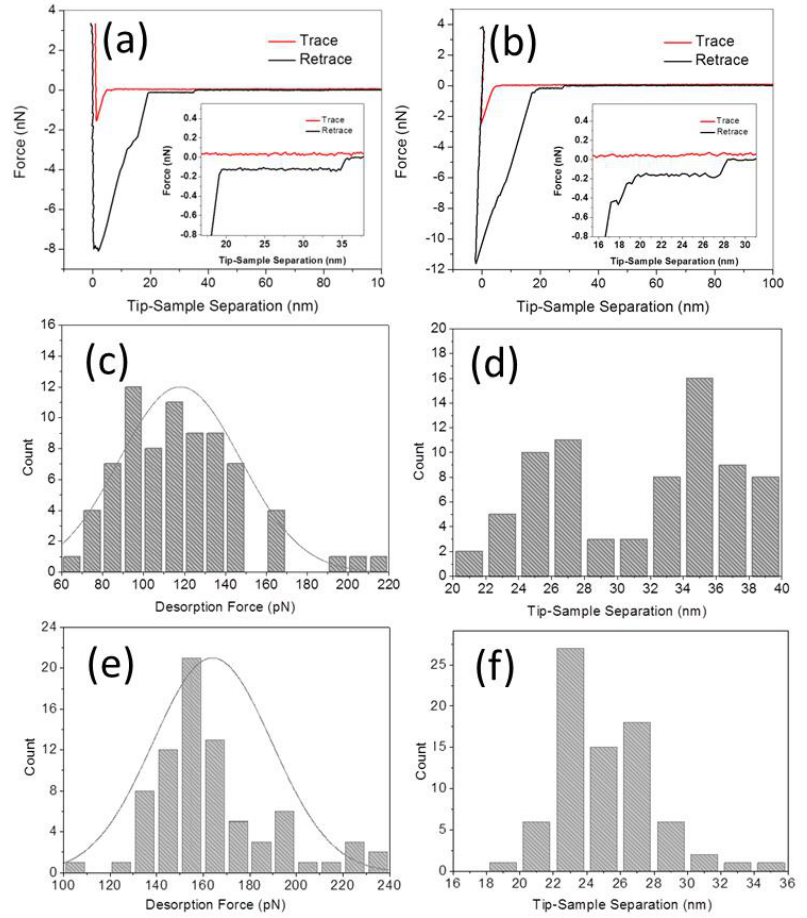
Figure 4. SMFS experiments and statistical analysis: ( a , b ) Typical FD curve by peeling aptamer from graphite surface ( a ) before and ( b ) after adding 1 μM adenosine; ( c , d ) Distributions of the desorption forces and tip-sample separations corresponding to the FD curves of ( a ); ( e , f ) same, for the FD curves of ( b ). After the adding of adenosine, the mean desorption force by peeling aptamer from graphite surface increased from 117.8 ± 29.5 to 164.3 ± 25.4 pN, and the mean tip-sample separation decreased from about 36.1 ± 2.0 to 25.2 ± 3.4